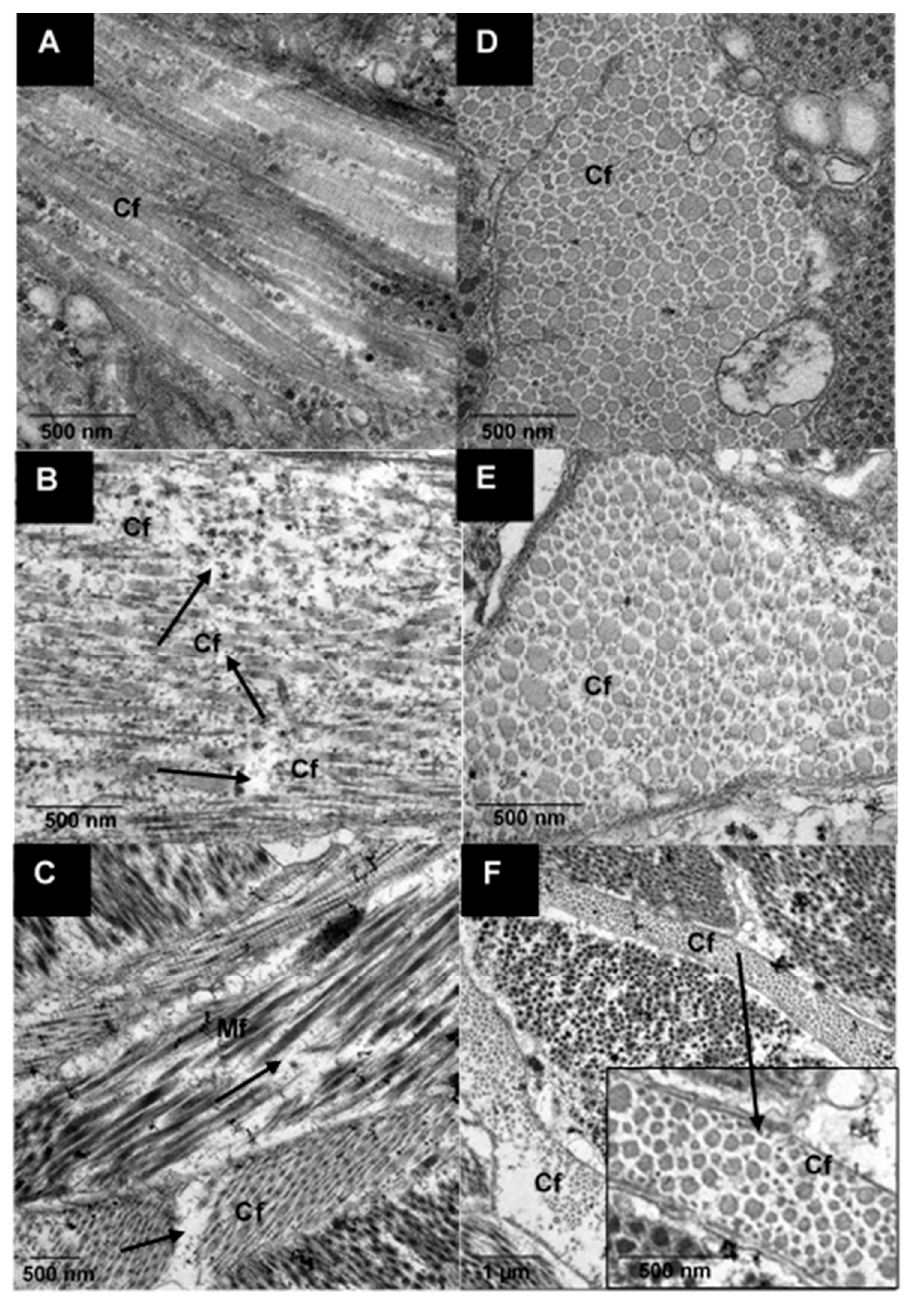
Figure 5. Transmission electron micrographs of raw p ā ua foot muscle tissue. Longitudinal ( A , B ) and transverse ( D – F ) views of the ( A , D ) untreated, ( B , E ) ultrasound treated in water for 5 min followed by soaking for 24 h and ( C , F ) ultrasound treated in 1% actinidin solution for 5 min; (Mf) myofibrils, (Cf) collagen